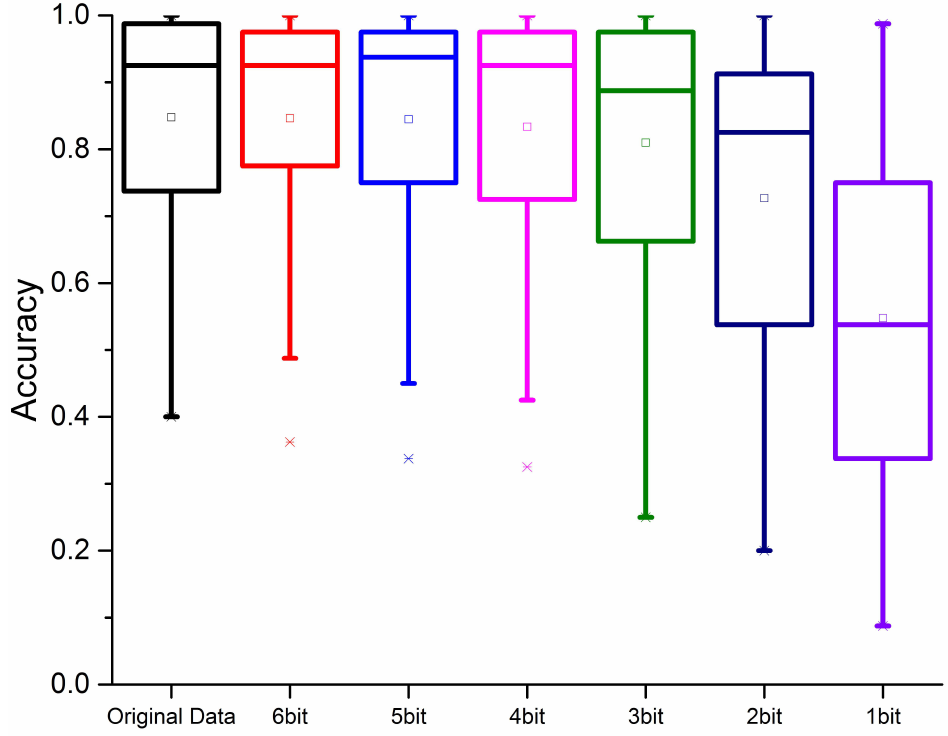
Figure 9. Influence of different quantization bits on SSVEP